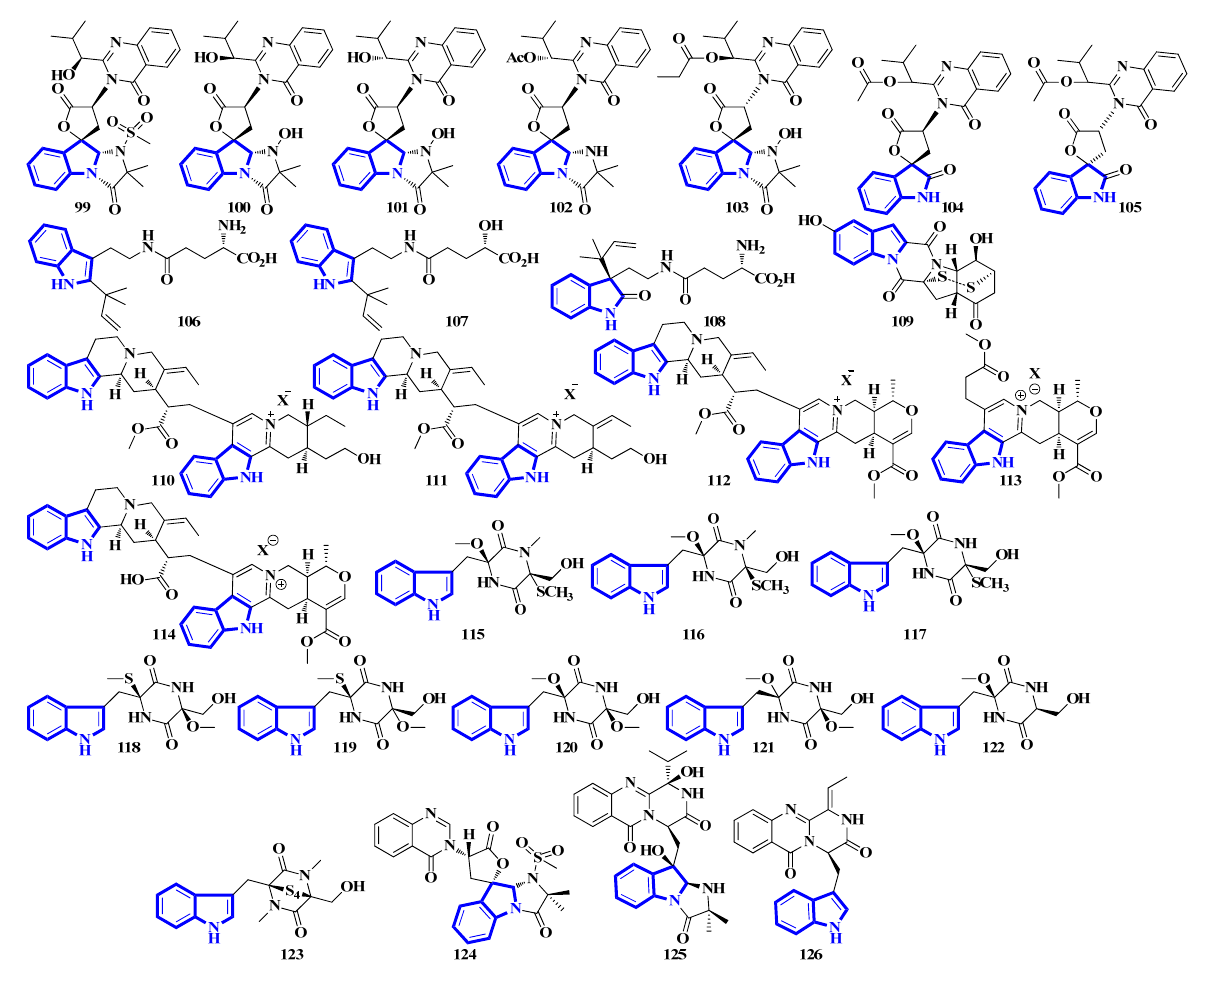
Figure 7. Novel indole alkaloids 99 to 126 .